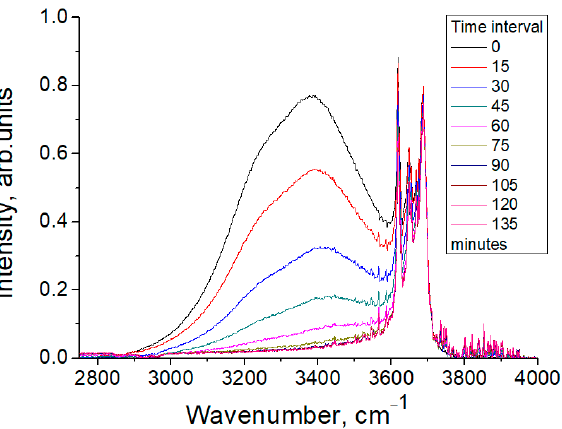
Figure 10. Profiles of 2750–4000 cm − 1 bands in kaolinite moistened to 26% during its drying for 135 min. The measurements were made with a step of 15 min.